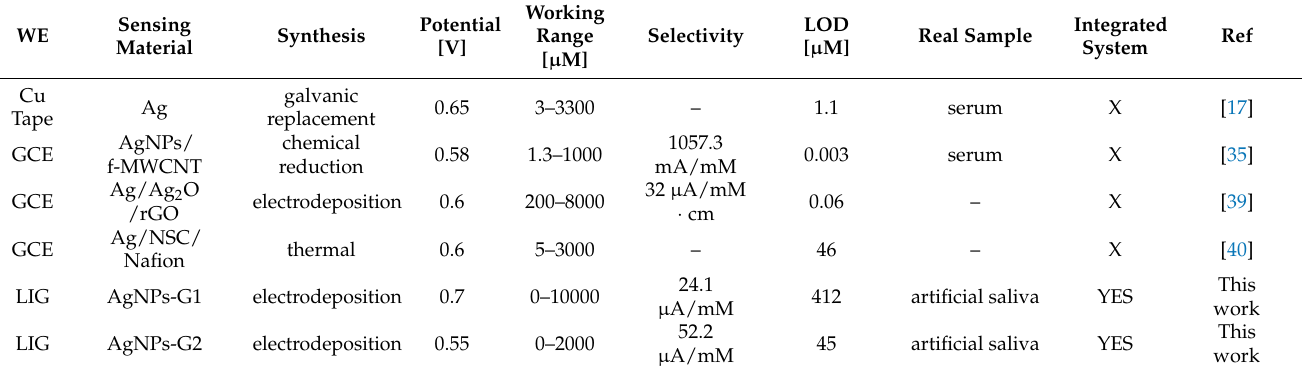
Figure 9. Amperometric glucose detection; ( a ) G1 region at 0.7 V and the obtained calibration curve ( b ), ( c ) G2 region at 0.55V, and the obtained calibration curve ( d ). Table 1. Comparison of LIG/AgNPs with Ag-based composites for non-enzymatic glucose